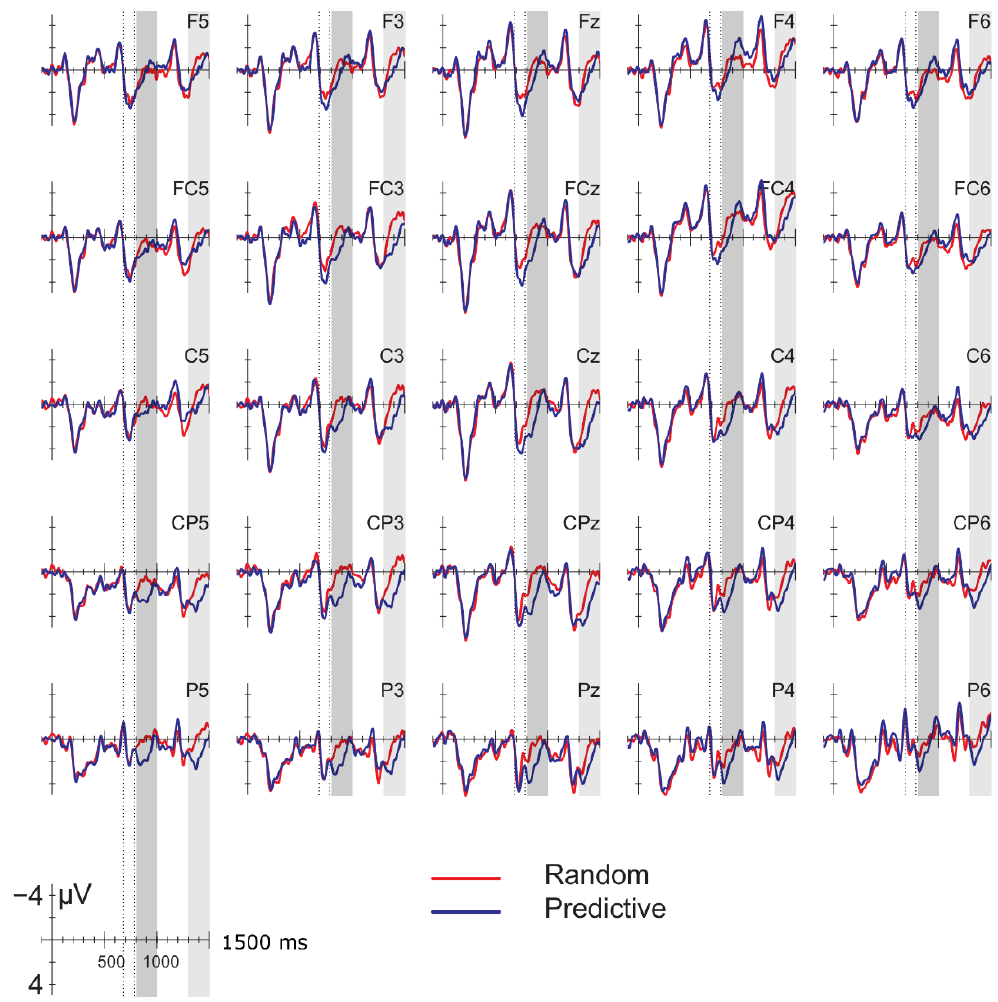
Figure 5. ERPs time-locked to the onset of the first letter in the sequence. ERPs are baselined to 100 ms preceding the onset of the first letter. Letters are presented for 300 ms, starting at 0 ms, 500 ms and 1000 ms. Blue line: predictive (alphabetic) condition; red line: random condition. Dotted lines: window for the analysis of the P2; shaded intervals: windows used for the analysis of the negativity (dark bar: 800–1000 ms; light bar: 1300–1500